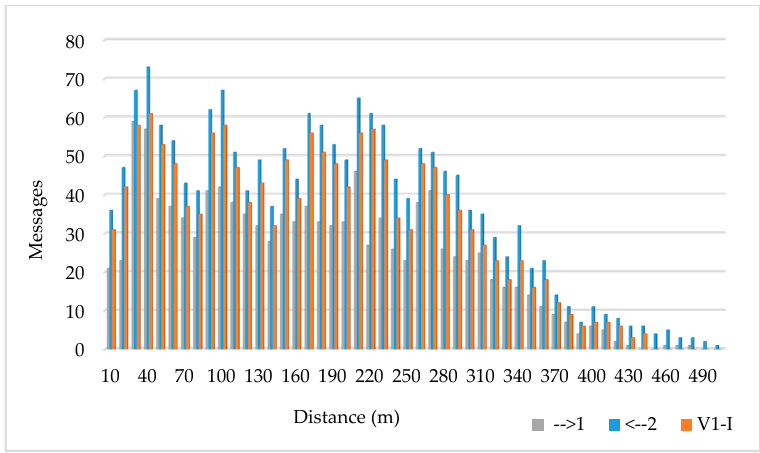
Figure 10. Messages transmitted by vehicle v1 and received by v2 and by the infrastructure.